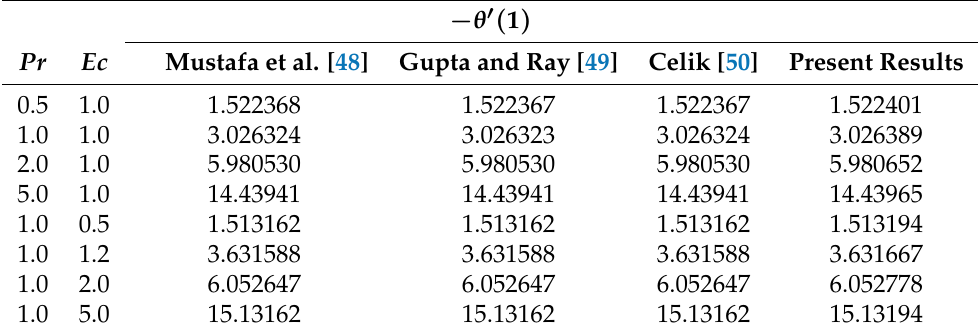
Table 3. Numerical outputs of the Nusselt number for Pr and Ec when λ 1 → ∞ , Da → ∞ , De = N b = 10 − 10 , Ha = γ = N t = 0, δ = 0.1, S = 0.5 and Le = R =